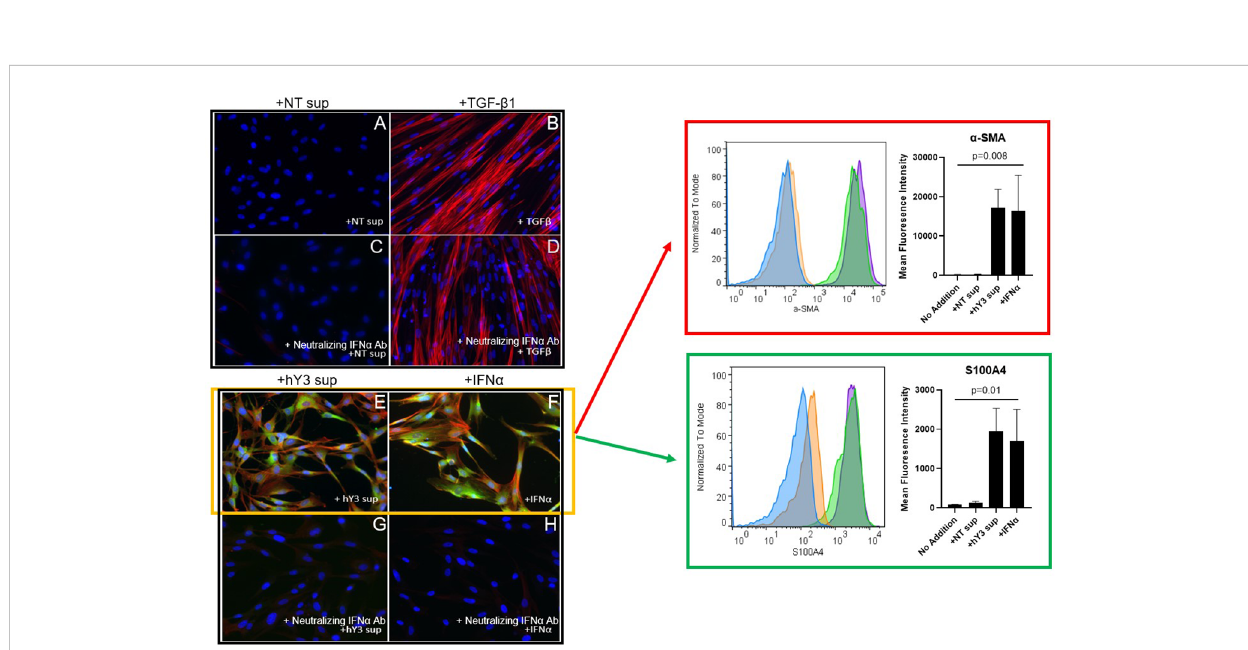
FIGURE 4 Phenotype of hY3-generated macrophage supernatants but not TGF- b 1 on fetal cardiac fi broblasts is sensitive to co-incubation with a neutralizing anti-interferon antibody. Fibroblasts isolated from healthy fetal hearts were incubated with hY3 sup or IFN a for 72 hours and then stained for a -SMA and S100A4 by indirect immuno fl uorescence (E, F) or fl ow cytometry (red and green boxes). No expression for either a -SMA or S100A4 was observed with the addition of NT sup (A) . Incubation with supernatants from hY3-transfected macrophages again resulted in dual positive shifts in a -SMA and S100A4 expression (E) . The direct addition of IFN a , unlike TGF- b 1 (B) , also generated dual expression of both markers (F) . Panels within red, green boxes show the quanti fi cation of the average (mean fl uorescence intensity) over three fl ow cytometry experiments. Conditions at bar graphs represent mean ± SEM. In sum, the fl ow cytometry authenticated the results using immuno fl uorescence staining. A neutralizing antibody to IFN a was added to each of the four conditions (C, D, G, H) . The neutralizing antibody to IFN a prevented the dual generation of S100A4, a -SMA populations in fi broblasts treated with IFN a (G) as well as with hY3 sup (H) . TGF- b 1-stimulated a -SMA expression was unaffected by the neutralizing antibody (D) .